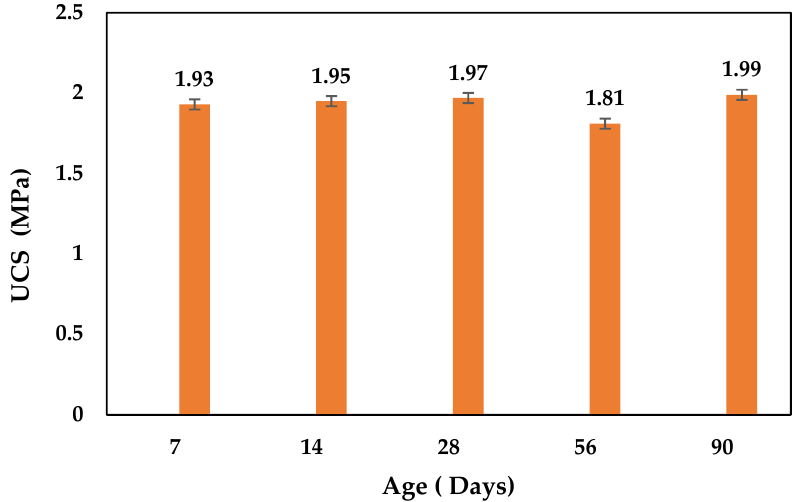
Figure 7. UCS of WFGD gypsum bricks at various curing times.